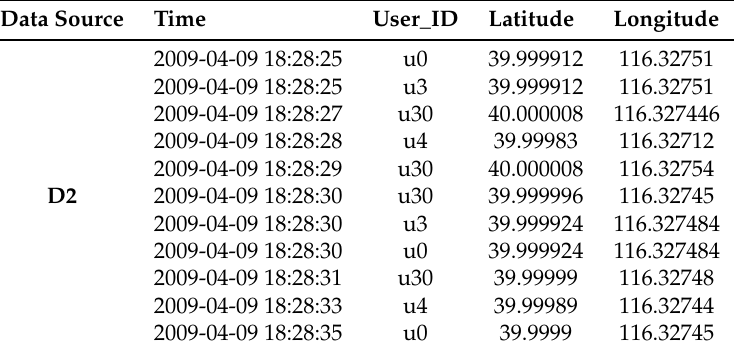
( b ) sub-figure 2. Figure 8. ( a , b ) Typical results in D2 . Table 8. Partial Data of Experimental